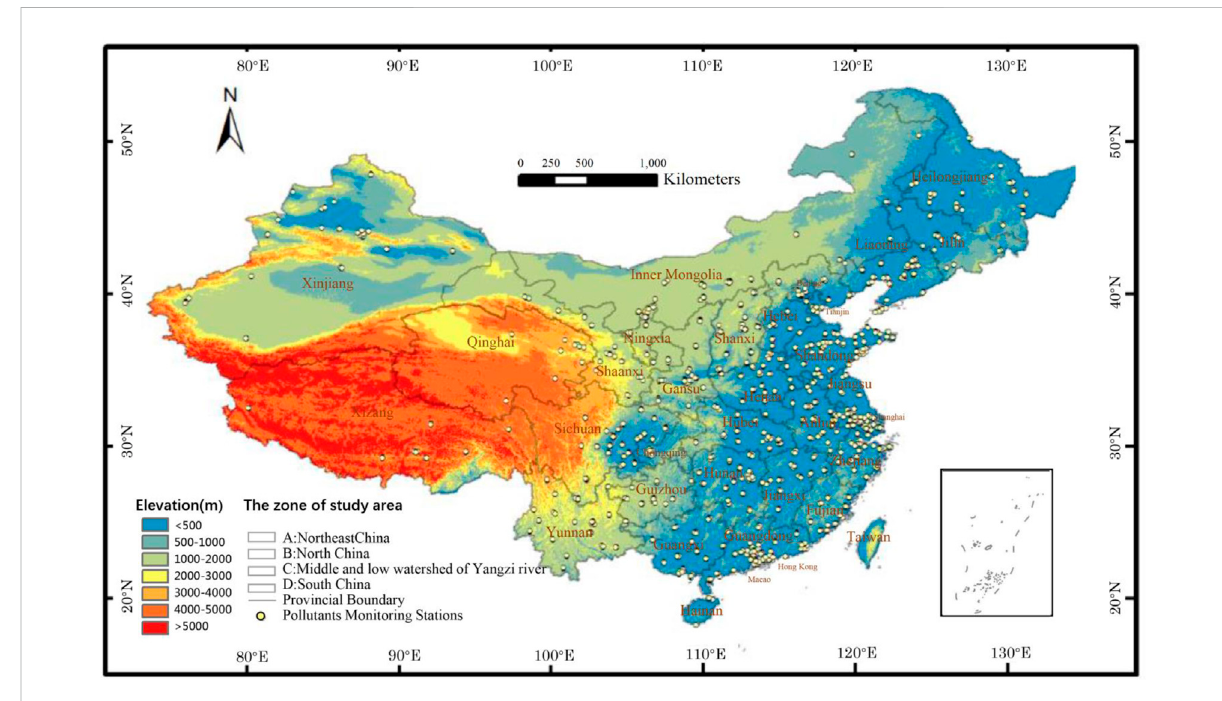
FIGURE 1 Spatial distribution of air quality stations in China and the study area and